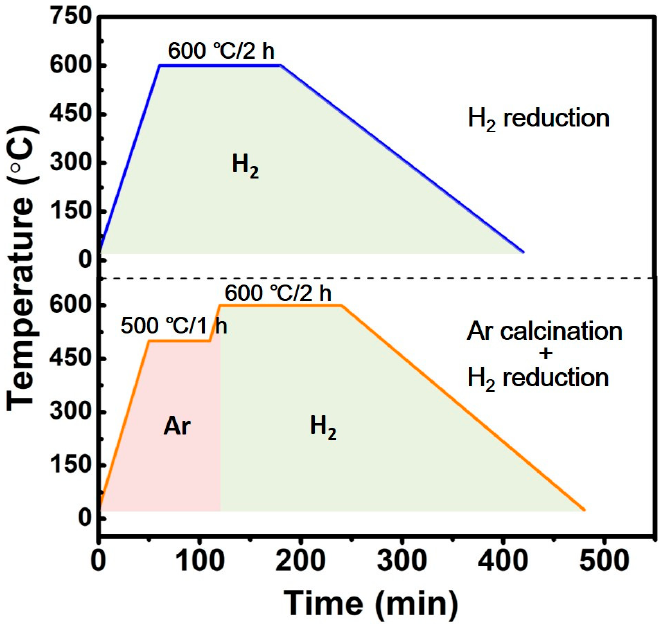
Figure 1. Direct H 2 reduction process and Ar calcination-H 2 reduction process for MoO 2 precursors.